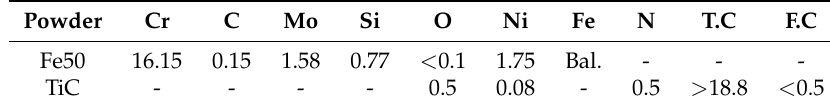
Table 2. Chemical composition of Fe50 and TiC